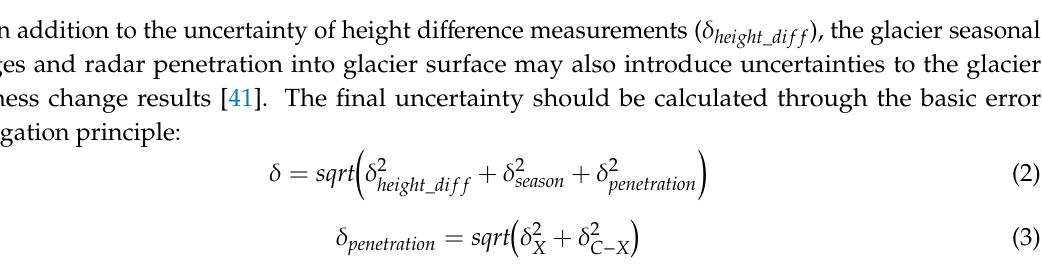
Figure 6. Distributions of nonglacial height-di ff erence observations. ( a ) PRISM DEM (2010)–SRTM-C DEM (2000) and ( b ) TanDEM-X DEM (2012)–SRTM-C DEM